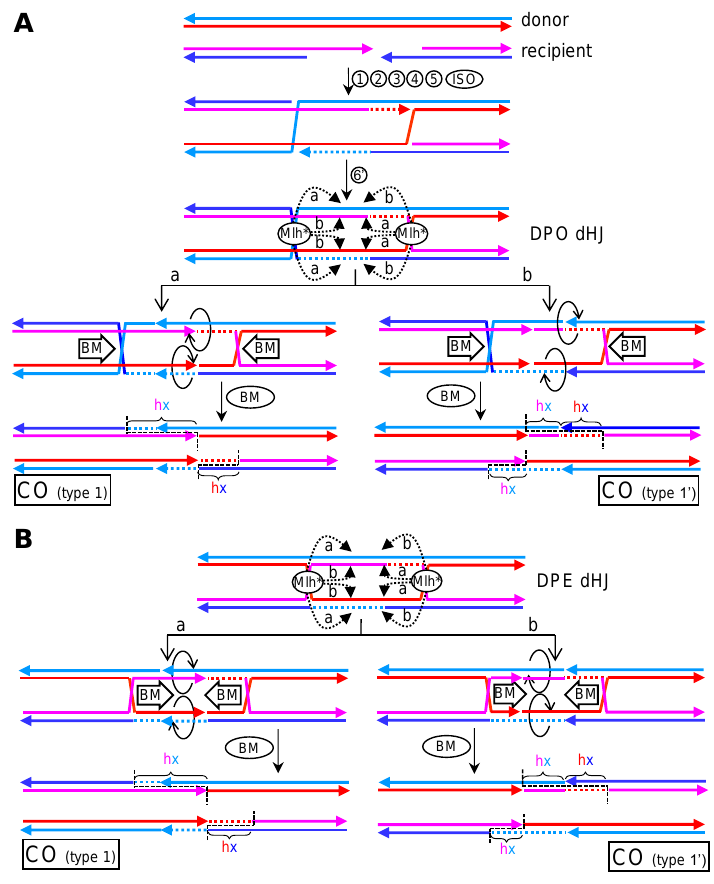
Figure 10. Models for type 1 CO specificity of ZMM meiotic resolution based on Mlh1-Mlh3 making incisions in trans . ( A ) Inward nicking by Mlh1-Mlh3 upon a DPO dHJ. Steps (1–5) are like in Figure 7A, and includes the nHJ isomerization (ISO) of Figure 7B. In step 6′, Mlh1-Mlh3 polymerizes inwards from the cHJs/nHJs (cHJs in this example). The main restriction of the model is that incisions in trans takes place with strand specificity relative to the nucleating HJ: “a” for crossover strands and “b” for non-crossover strands; “a” is also compatible with targeting first incisions to the newly synthesized strand sections. Branch migration towards the opposing nicks results in the resolution of the cHJs. ( B ) First incisions targeted by the newly synthesized strand section also predict type 1 COs in DPE dcHJ.